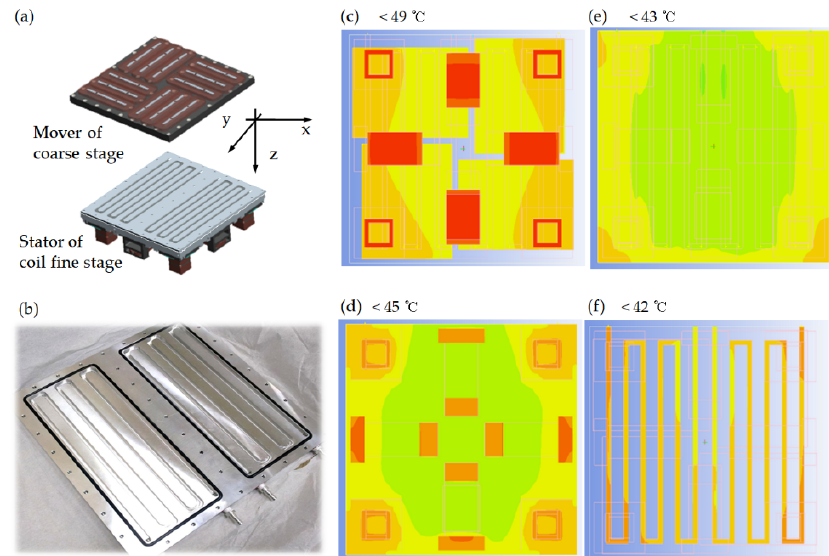
Figure 6. FE analysis results of the water-cooling heat exchanger: ( a ) configuration of the heat ex- changer; ( b ) coolant channel engraved on the stator of the fine stage ( c ) temperature at the coils; ( d ) temperature at the aluminum block (the stator of the fine stage); ( e ) temperature at the ceramic block (the stator of the coarse stage) ( f ) temperature at the coolant.